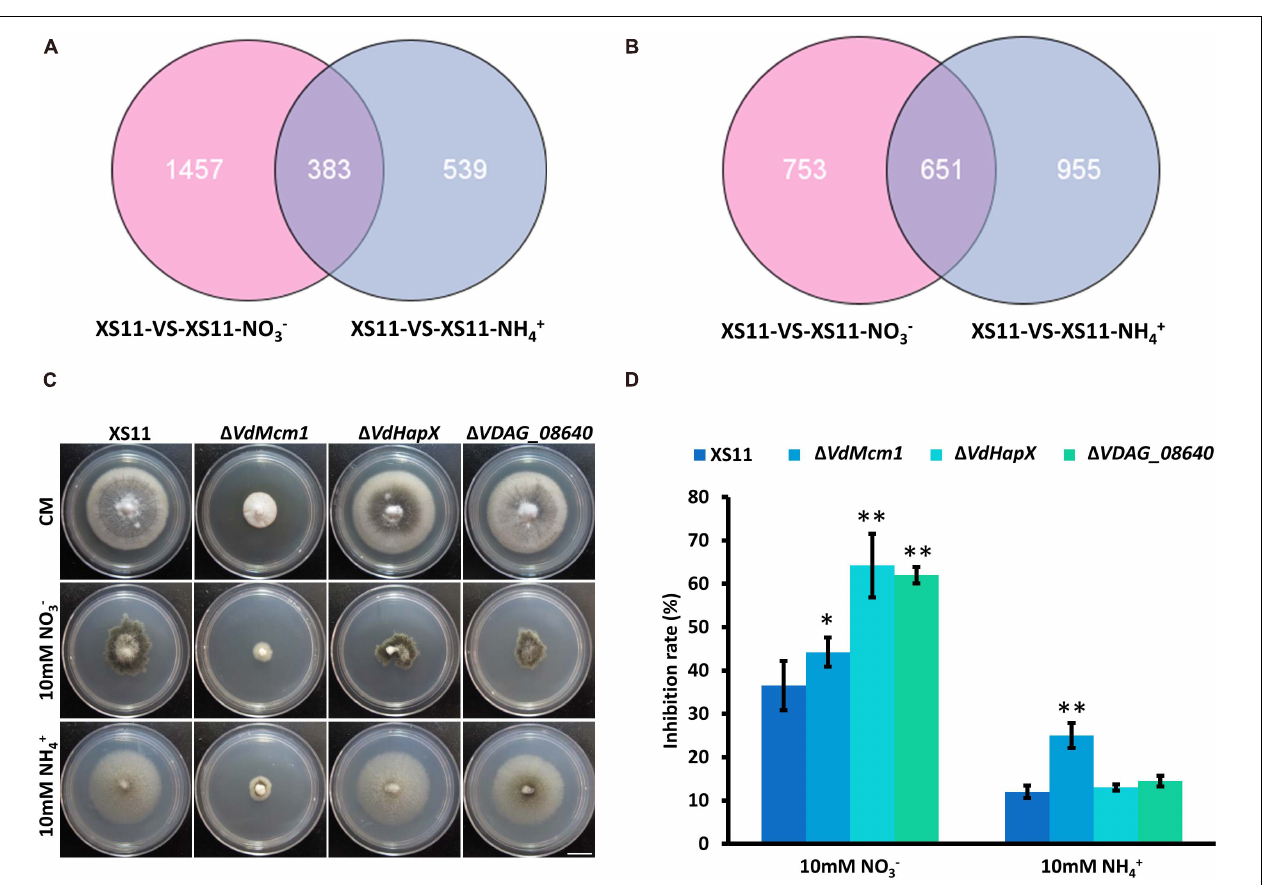
FIGURE 7 | Upregulated and downregulated differentially expressed genes (DEGs) in response to two different nitrogen sources in Verticillium dahliae. (A) The Venn diagram shows the number of DEGs upregulated in the treatments of strain XS11 of V. dahliae . The treatments included 10 mM nitrate (NO3 − ) or 10 mM ammonium (NH4 + ) amendments, and control. The sum of numbers in each circle represents the total number of DEGs between the two samples; overlapping parts of the circle represent commonly expressed DEGs between the two treatments. Scale = 1.33 cm. (B) Venn diagram showing the number of DEGs downregulated in treatments. The sum of numbers in each circle represents the total number of DEGs between the two samples; overlapping parts of the circle represent commonly expressed DEGs between the two treatments. (C) All strains were grown for 10 days on CM and GMM with 10 mM of the indicated sole nitrogen source including NO 3 − and NH 4 + at 25 ◦ C. Photographs were taken at 10 dpi of the media. (D) The chart illustrates the inhibition rates of the above colonies at 10 dpi. Error bars represent the standard deviation based on three independent replicates. Asterisks indicate significant differences ( ∗∗ P < 0.01; ∗ P <